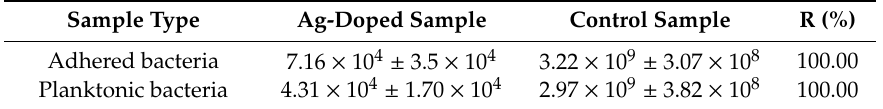
Table 5. Antibacterial test results presenting bacterial count (CFU/mL) and antibacterial rate (%).